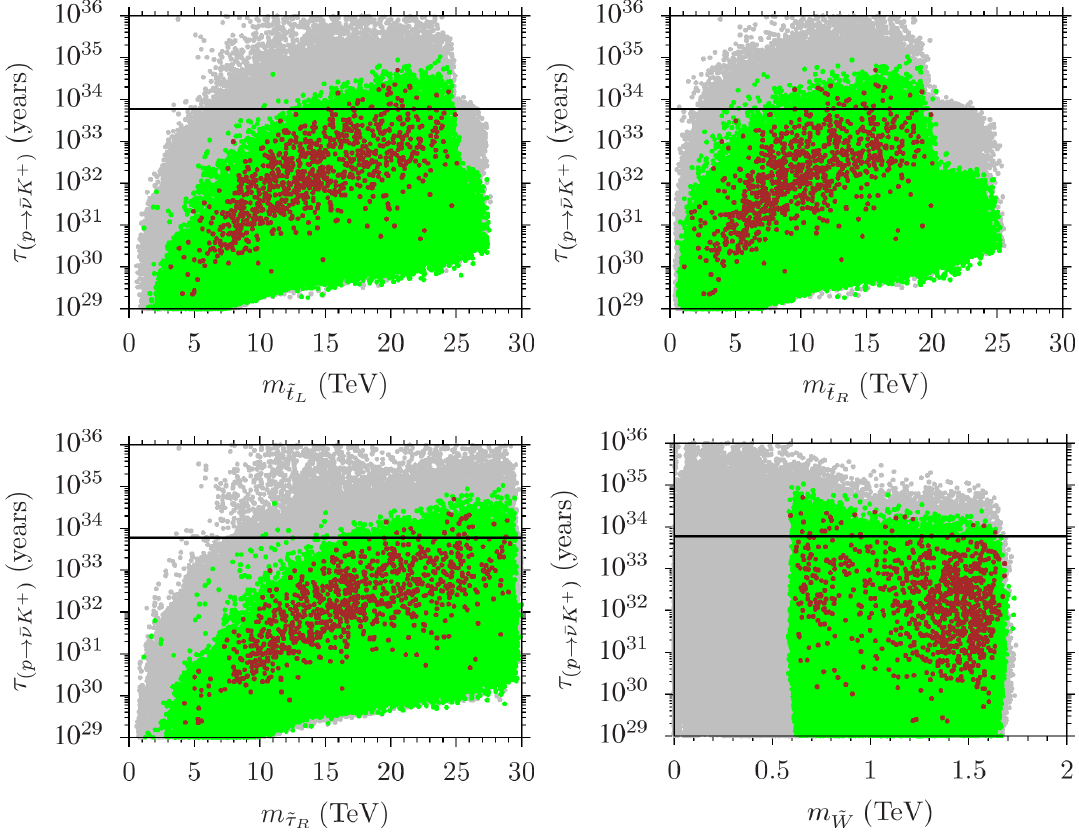
Figure 7 . Correlations of proton lifetime with the masses of the left and right-handed stops, right- handed stau and wino respectively. Proton life time is calculated by setting M H and the color coding is the same as figure